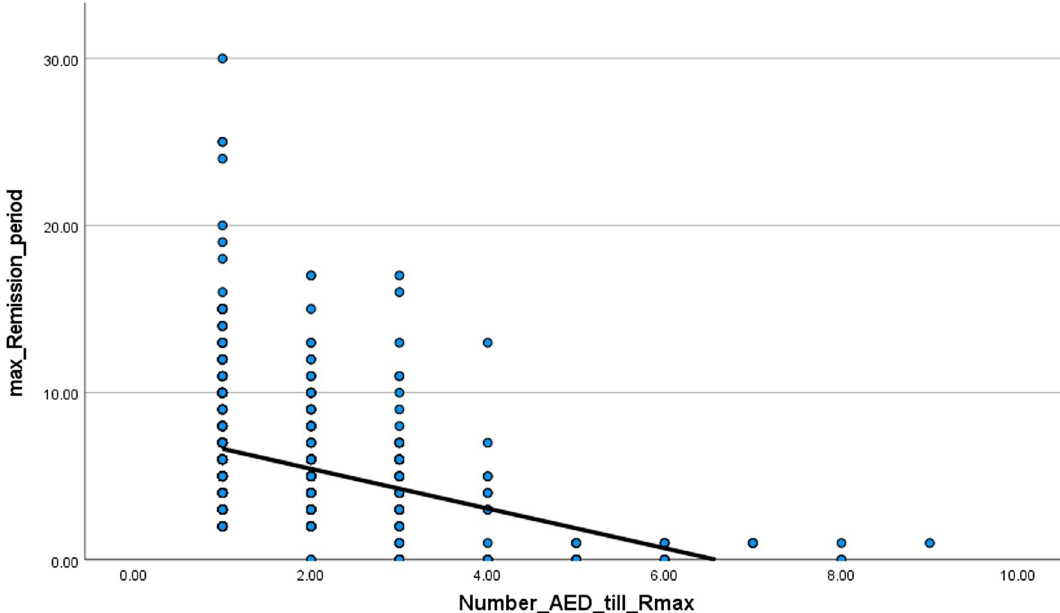
Fig. 1 Correlation between number of AEDs till achievement of maximum remission period and maximum remission